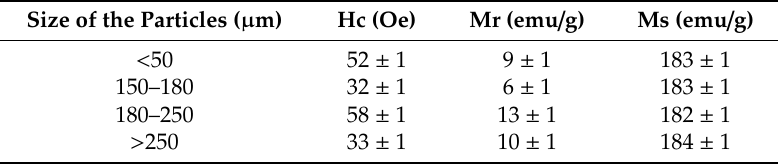
Table 2. Magnetic properties of the particles in function of the size.